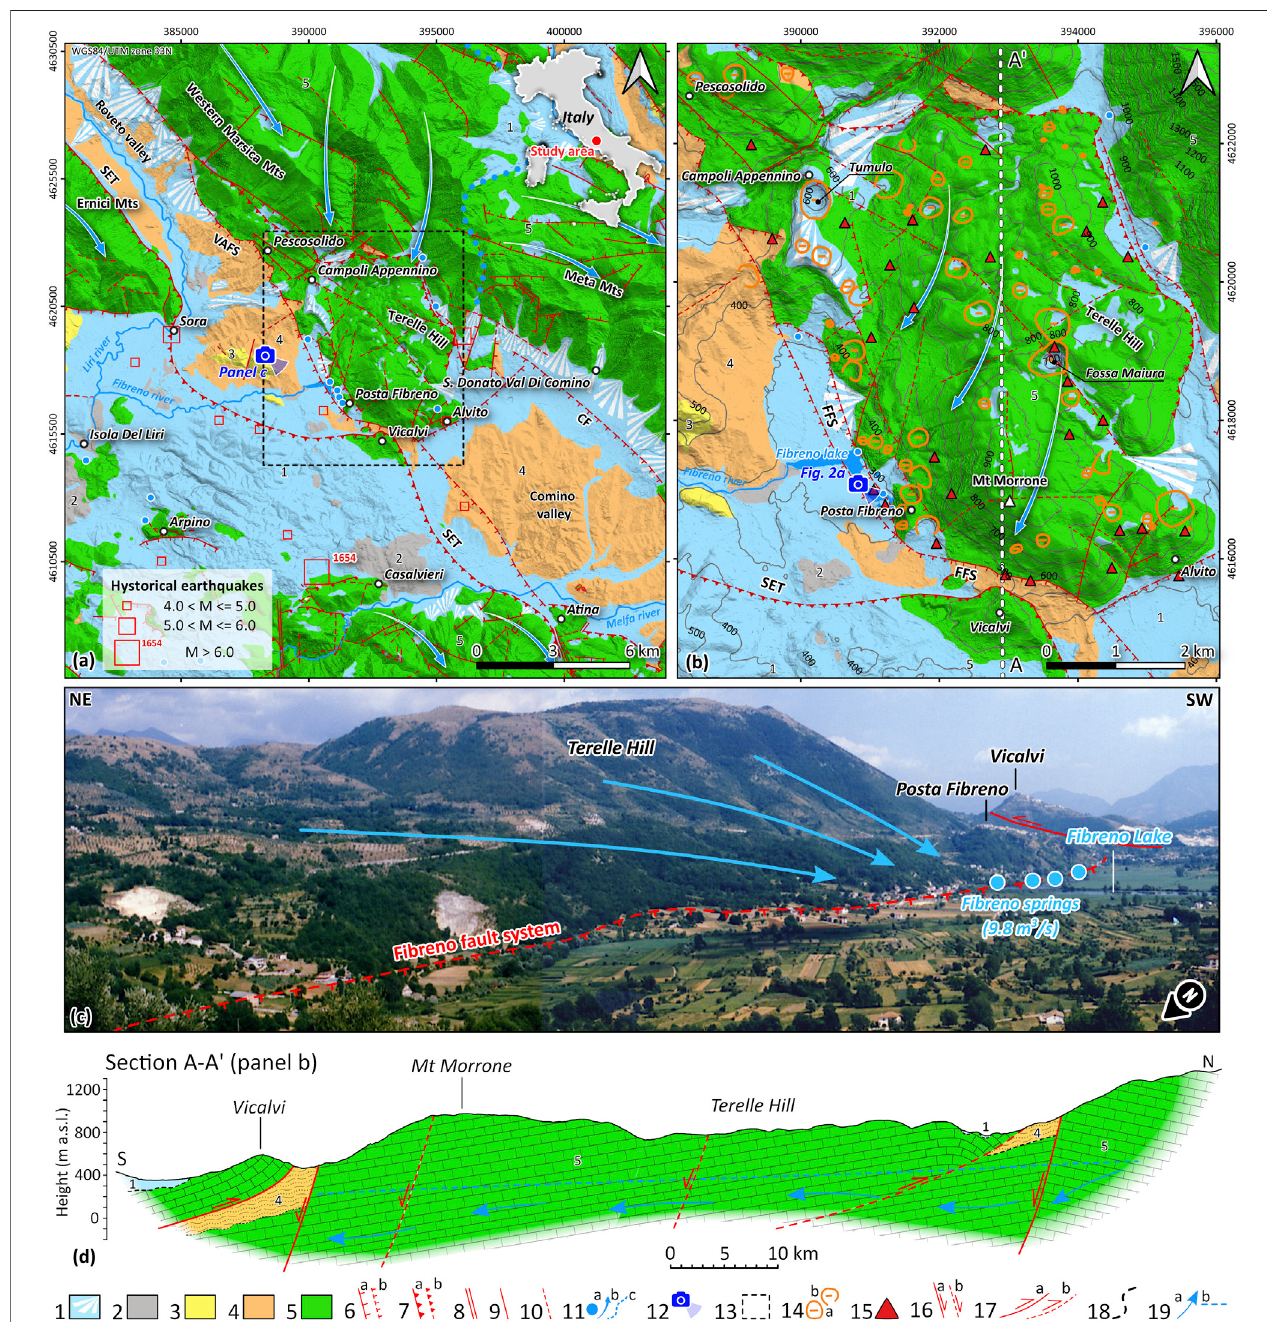
FIGURE 1 | Geological and hydrogeological sketch of the study area. (A) Overview of Roveto and Comino valleys (southern and northern sectors, respectively), showing main tectonic features and pre-Quaternary and Quaternary deposits, modi fi ed from Saroli et al. (2003). Historical earthquakes with magnitude M > 4 are taken from the parametric catalogue of Italian earthquakes (Rovida et al., 2021). The date of the main event which struck the investigated area has been reported in red. (B) Detail of the inset in panel A. (C) Panoramic view of the Terelle Hill area; the Fibreno fault (dashed red line), springs and Fibreno lake have been indicated. (D) Hydrogeological cross-sectionalongtheA-A ′ pro fi leinpanelb,modi fi ed fromSaroliet al.(2003).Keytothelegend:1)Recentand olddebris,debrisfan,eluvial,colluvial and lacustrine deposits (upper Pliocene - Holocene). 2) Travertine (middle Pleistocene - upper Pleistocene). 3) Gravel and sand (Messinian - lower Pliocene). 4) Sandstone and grey clay ( fl ysch) (upper Tortonian). 5) limestone and dolostone with hemipelagic marl (Lias - lower Tortonian). 6) Normal fault: (a) certain, (b) inferred 7) Thrustfault:(a)certain,(b)inferred.8)Strike-slipfault.9)Faultswithcomplexkinematics.10)Inferred/buriedfault.11)(a)springorgroup ofsprings,(b)groundwater fl ow, (c) groundwaterdivide.12)Locationand orientationofpictures. 13)Detail ofthestudyareainpanelb.14)Doline:(a) closed,(b)open.15)Locationofthegeomechanical surveys.16)Normalfault(paneld):(a)certain,(b)inferred.17)Thrustfault(paneld):(a)certain,(b)inferred.18)Inferredlithologicalboundary(paneld).19)(a)groundwater fl ow, (b) groundwater table (panel d).